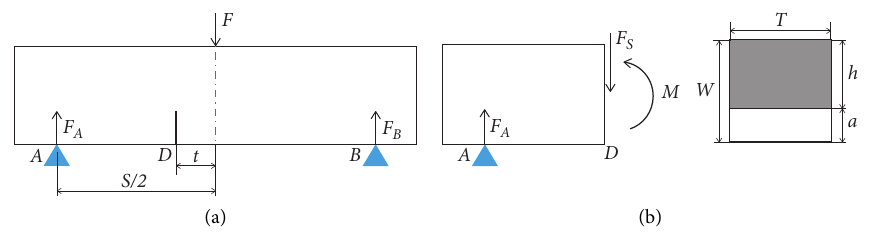
Figure 14: The schematic diagram of the CCB with offset notch. (a) The diagram of the CCB; (b) the cross section of